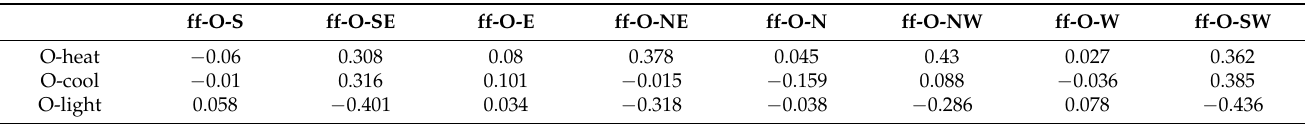
Table 9. Correlation coefficients between energy demands of canteen and its design indicators.